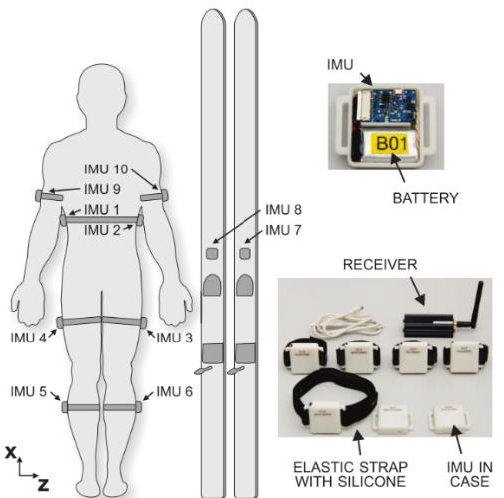
Figure 14. IMU placement landmarks and sensor design according to the protocol proposed by [72].